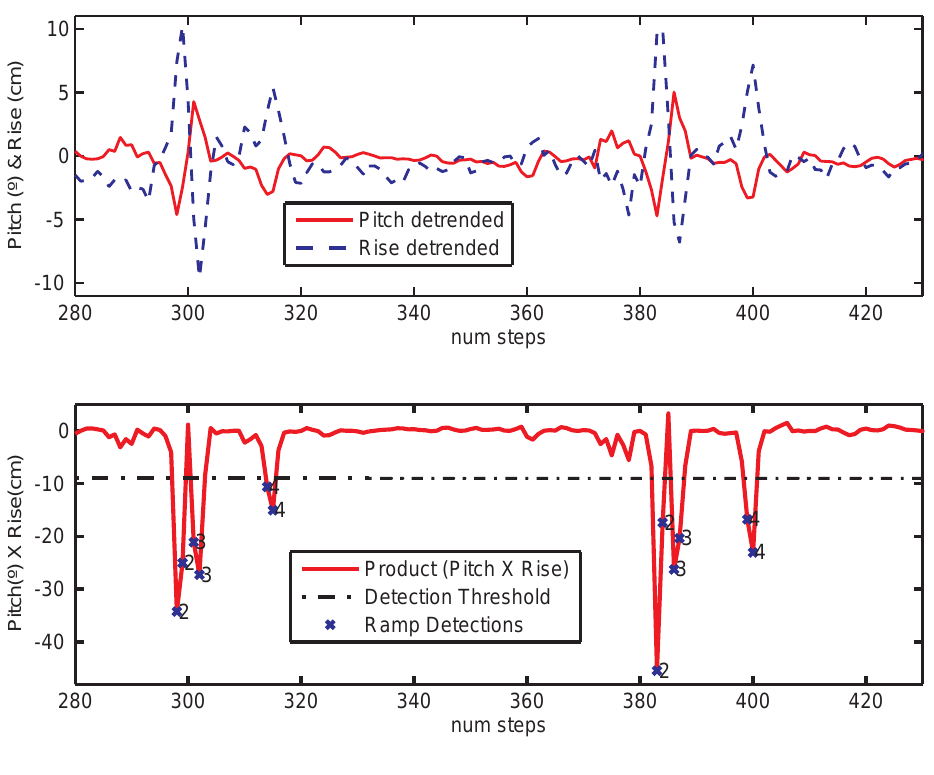
Figure 5. Ramp detections and associations, for 2 repetitions of a test visiting ramps 2, 3 and 4. Top graph: Estimated Pitch and Rise. Bottom graph: Ramp detections (crosses) and the identification of ramps after the association (marked with the number of the associated